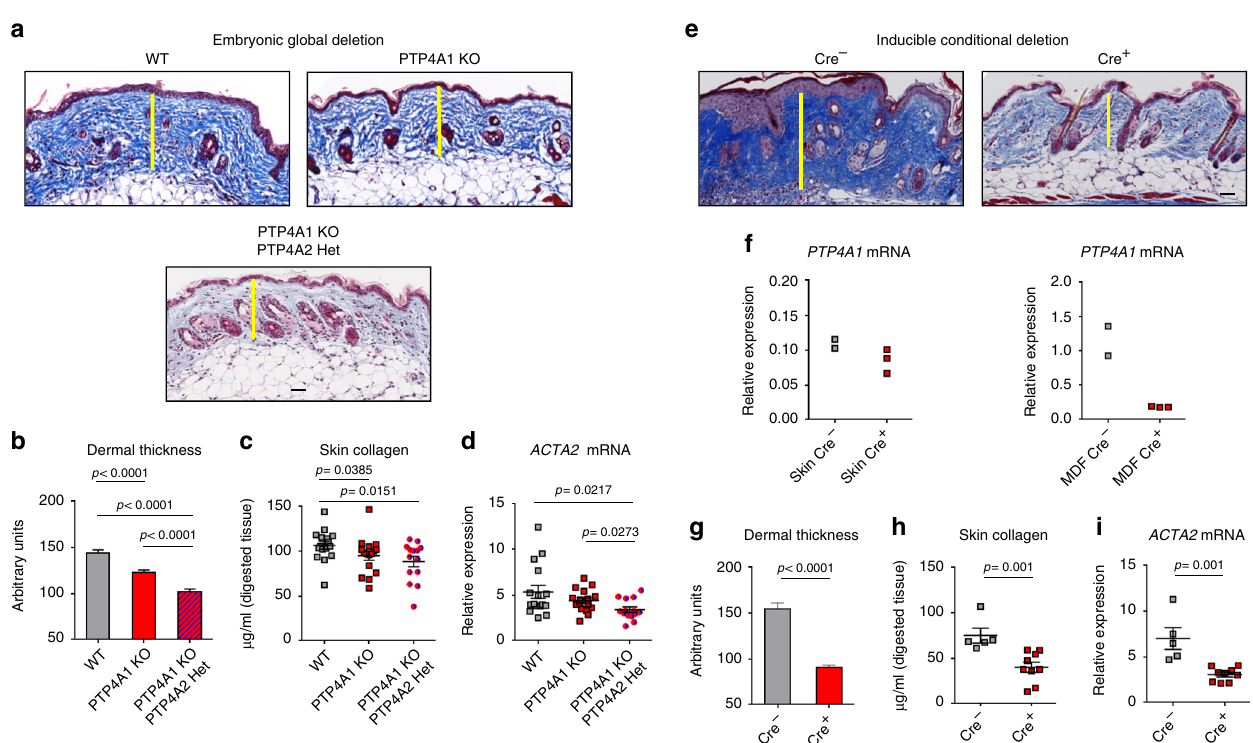
Fig. 4 PTP4A1 silencing protects mice from dermal fi brosis. Masson ’ s trichrome-stained skin sections from bleomycin-treated mice. Images are representative of 16 WT, 16 PTP4A1 KO, and 14 PTP4A1 KO/PTP4A2 Het mice ( a ), or 5 COL1A1Cre − /PTP4A1 fl / fl and 9 COL1A1Cre + /PTP4A1 fl / fl tamoxifen-induced mice ( e ). Graphs show mean ± SEM dermal thickness ( b , g , see yellow bars in a and e ), skin collagen concentration ( c , h ), and ACTA2 mRNA relative expression ( d , i ). f PTP4A1 mRNA relative expression in whole skin (left graph) or in isolated mouse dermal fi broblasts (right graph) from two COL1A1Cre − /PTP4A1 fl / fl or three COL1A1Cre + /PTP4A1 fl / fl mice. Mann – Whitney test. Scale bar, 50 μ